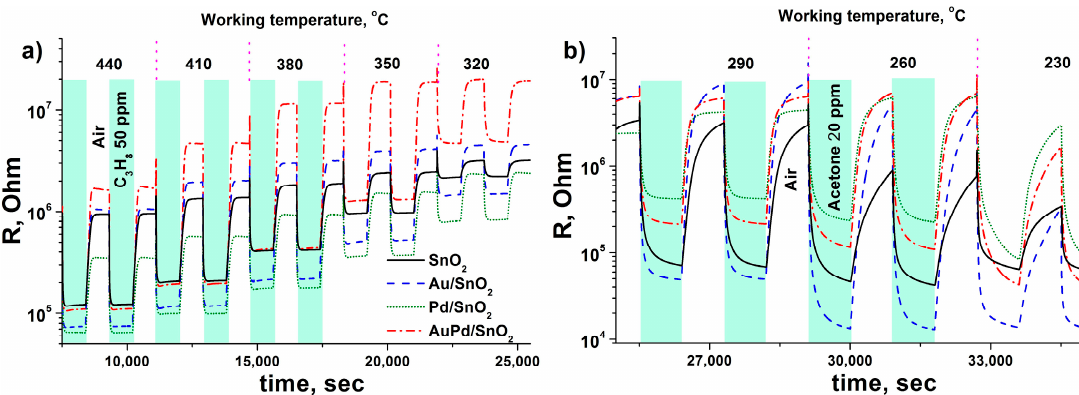
Figure 5. Resistance transients during the measurements of sensor response of synthesized materials at different working temperatures towards ( a ) C 3 H 8 50 ppm and ( b ) acetone 20 ppm. di ff erent working temperatures towards ( a ) C 3 H 8 50 ppm and ( b ) acetone 20